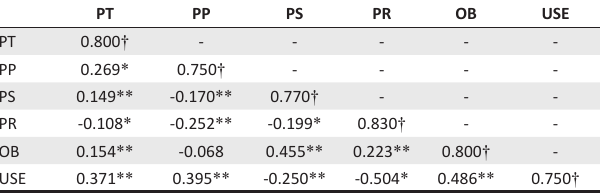
TABLE 2: Standardised construct correlation